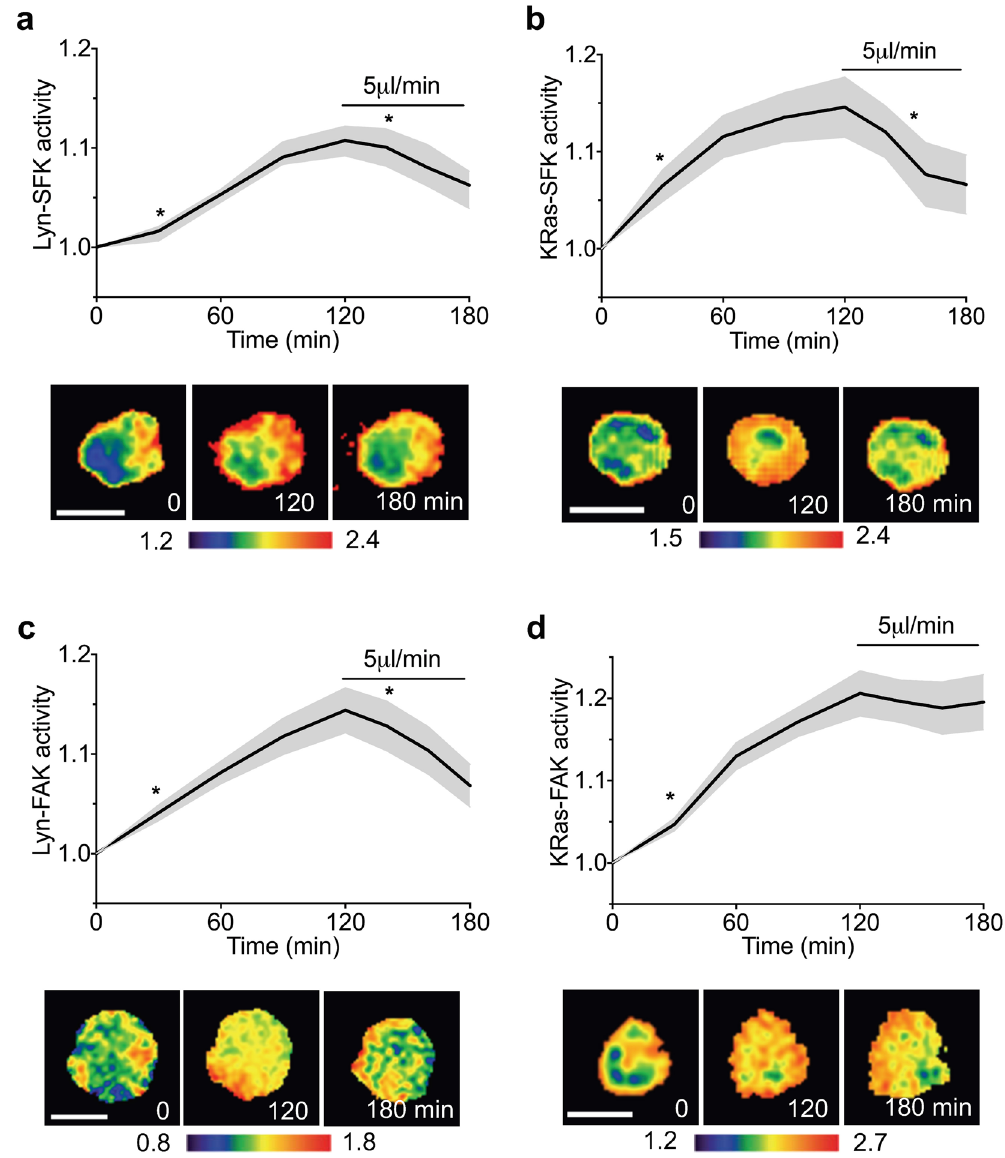
Figure 5. Intermediate level of fluid flow enables suppression of IL1 β -stimulated activation of Lyn-SFK, KRas- SFK and Lyn-FAK, but not KRas-FAK. Chondrocytes in mouse cartilage explants were transfected with one of the FRET biosensors. During imaging, cells were treated with 1 ng/ml IL1 β for 2 hours (0–120 min) and then subjected to 5 μ l/min fluid flow for 1 hour (120–180 min). The time course activities were normalized to the activities at 0 min. In the time course, * between 0 and 120 min ( + IL1 β ) indicates the time point after which the activity becomes significantly different from that at 0 min ( - IL1 β ), and * between 120 and 180 ( + IL1 β , + flow) min indicates the time point after which the activity becomes significantly different from that at 120 min ( + IL1 β , - flow). Representative FRET ratio images were scaled according to the corresponding color bar. Scale bars, 10 μ m. ( a ) Lyn-SFK activity ( n = 10). ( b ) KRas-SFK activity ( n = 13). ( c ) Lyn-FAK activity ( n = 18). ( d ) KRas-FAK activity ( n =